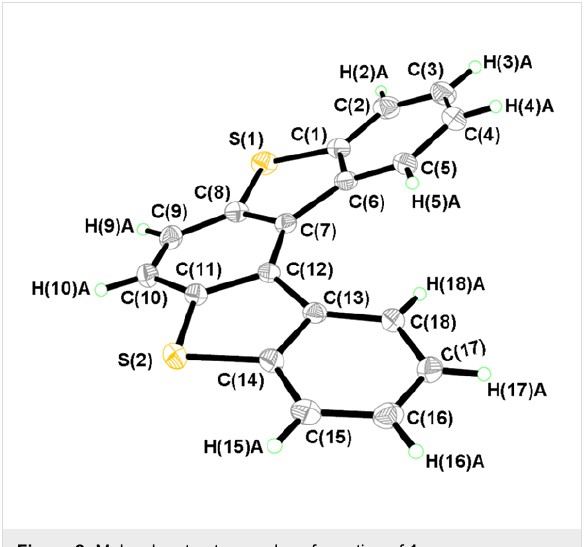
Figure 2: Molecular structure and conformation of 1